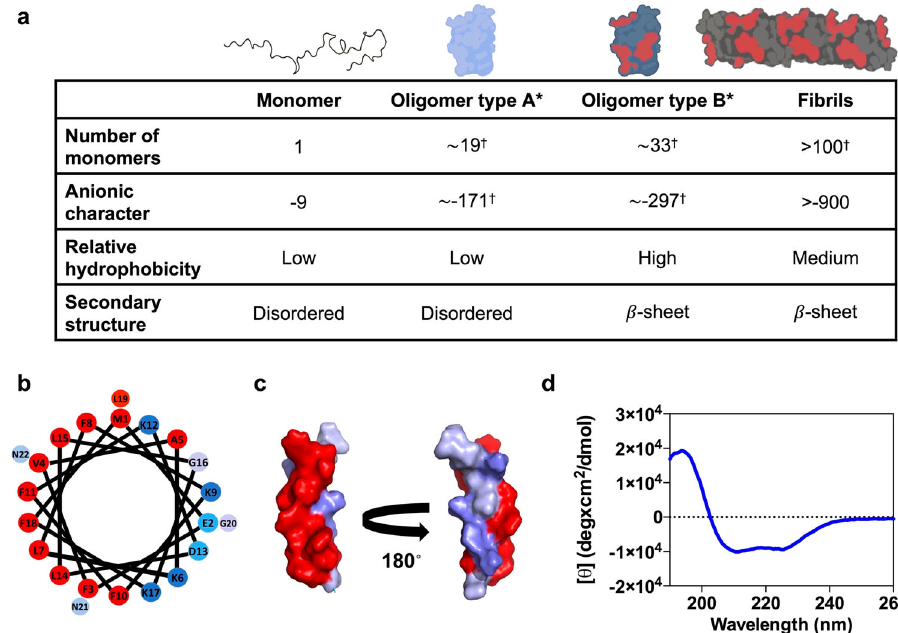
Fig. 1 Rational identi fi cation of a peptide ligand for α S toxic species. a Main molecular features of the four isolated α -synuclein ( α S) species. Values with a dagger ( † ) represent extrapolations based on the average number of monomers in each species. In the upper schemes of α S oligomeric and fi brillar species, the acidic C-terminal region is not depicted since it has been described to be in a disordered and conformationally fl exible state 21 – 23 . b Helical wheel projection of PSM α 3 sequence (red, hydrophobic residues; blue pallet, hydrophilic residues depending on their character). c Surface representation of the three-dimensional structure of PSM α 3 with hydrophobic residues in red and hydrophilic residues in blue. d Far-UV circular dichroism spectra of PSM α